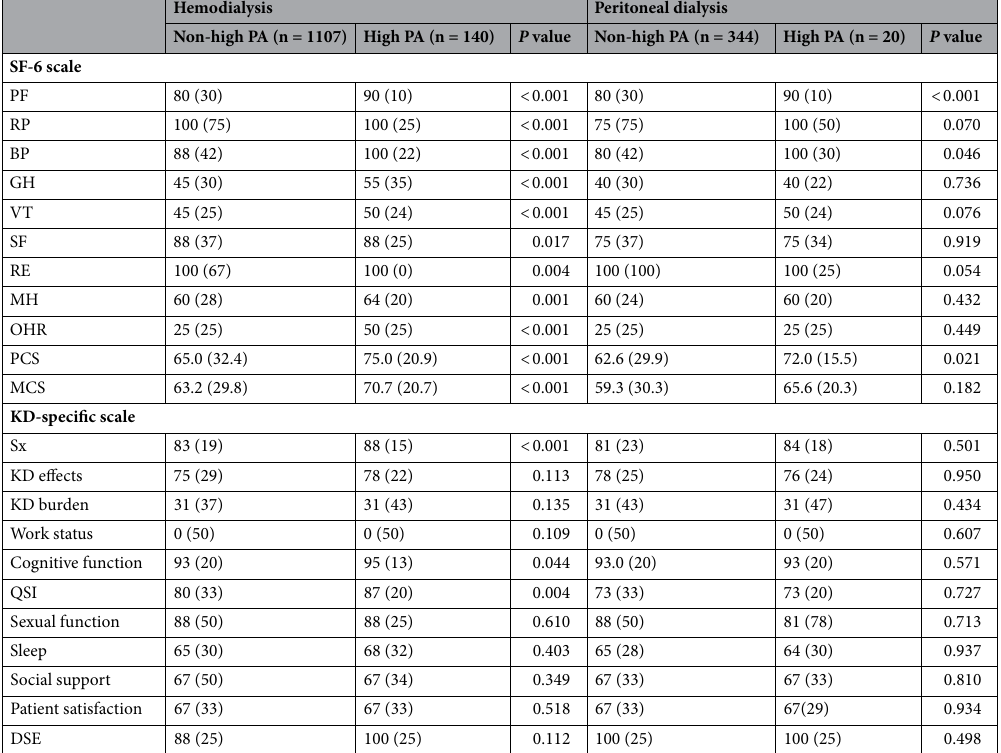
Table 3. Comparison of quality of life scale scores according to physical activity. Data are expressed as median (interquartile range). Comparisons between MET < 600 and ≥ 600 were tested using Kolmogorov– Smirnov z test. PA, physical activity; SF, short form; MET, metabolic equivalent of task; PA, physical activity; PF, physical functioning; RP, role limitations due to physical health problems; BP, bodily pain; GH, general health; VT, vitality; SF, social functioning; RE, role limitations due to emotional problems; MH, mental health; OHR, overall health rating; PCS, physical component scale; MCS, mental component scale; KD, kidney disease; Sx, symptom/problems; QSI, quality of social interaction; DSE, dialysis staff